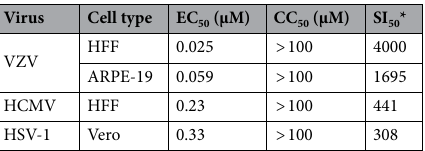
Table 1. Efficacy of H84T BanLec against human herpesviruses in cultured cells. *SI (selectivity index) calculated as CC 50 /EC 50